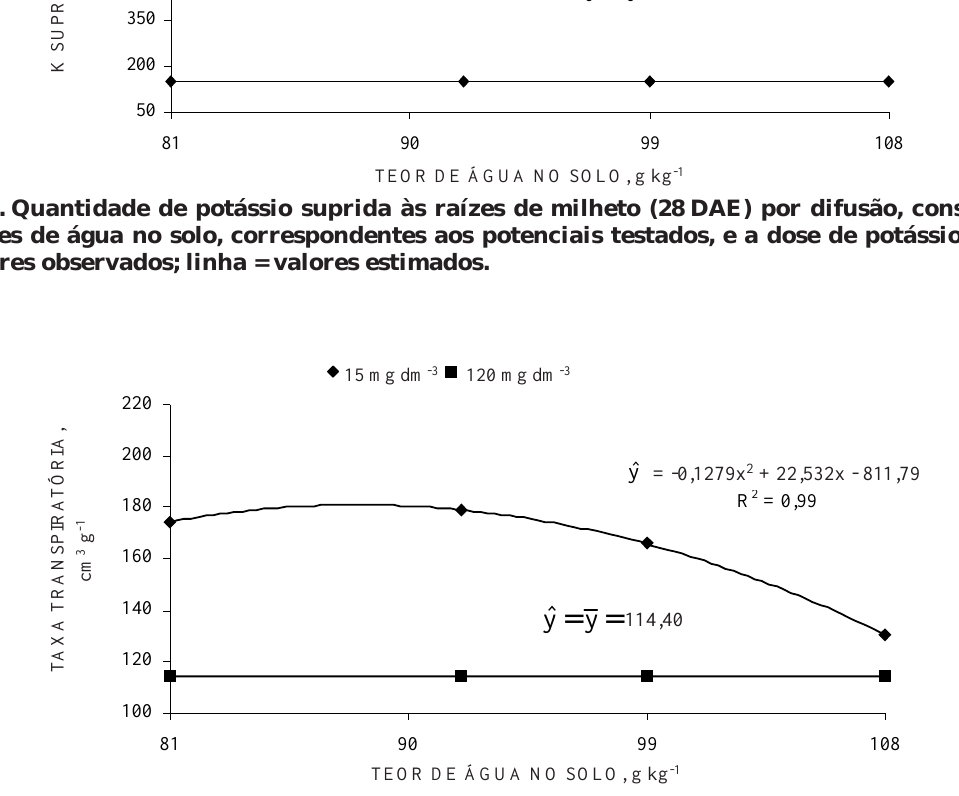
Figura 4. Taxa transpiratória do milheto (28 DAE), considerando os teores de água no solo, correspondentes aos potenciais testados, e as doses de potássio. Símbolos = valores observados; linha = valores